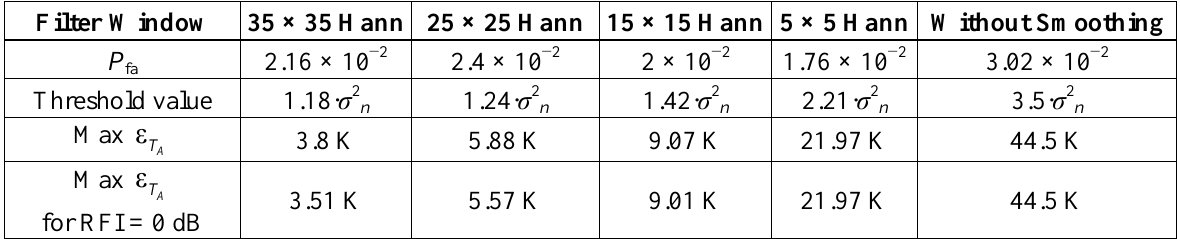
Table 2. Maximum retrieved T Smoothing Algorithm filtering, including the case of not applying the algorithm; for the OFDM interfering signal case. Maximum retrieved T suitable threshold is also